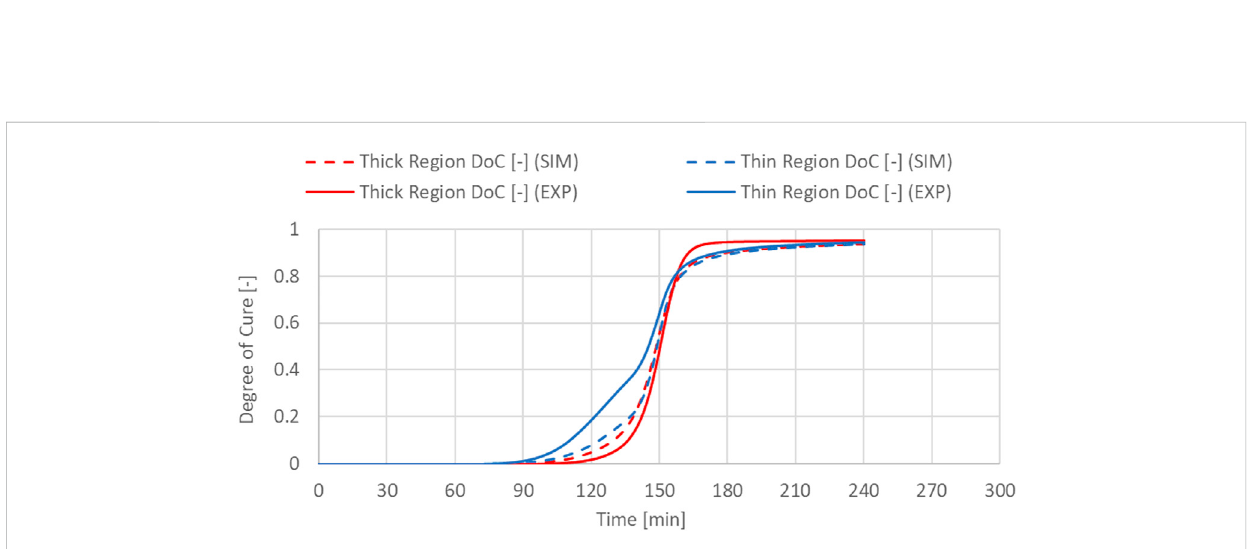
FIGURE 8 Degree of Cure calculated using simulated and measured temperature data at mid-thickness in thick and thin region for dual zone cure.